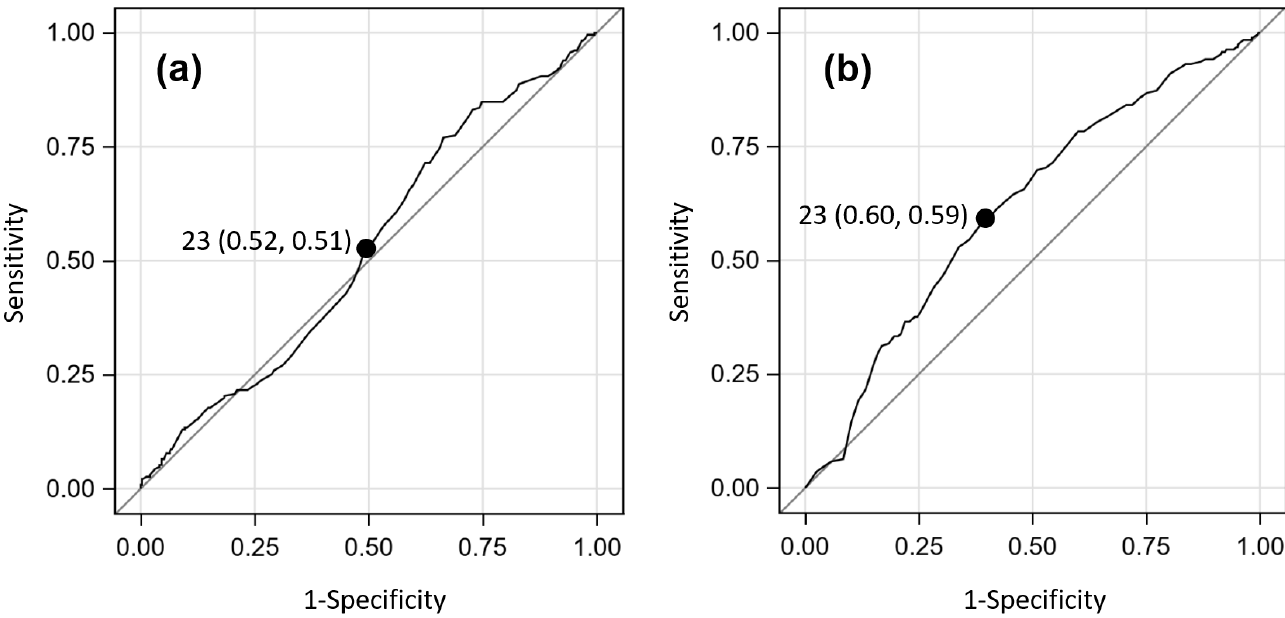
Figure 3. Receiver Operating Characteristic (ROC) analyses for subject age at clinical presentation for suspected Lassa fever cases. ( a ) ROC results for determining patient survival outcome on clinical presentation; ( b ) ROC result for determining acute Lassa fever seropositivity on clinical presentation. The leftmost numbers inside the plot are the age values, and the middle and rightmost values correspond to their respective sensitivity and 1-specificity values.